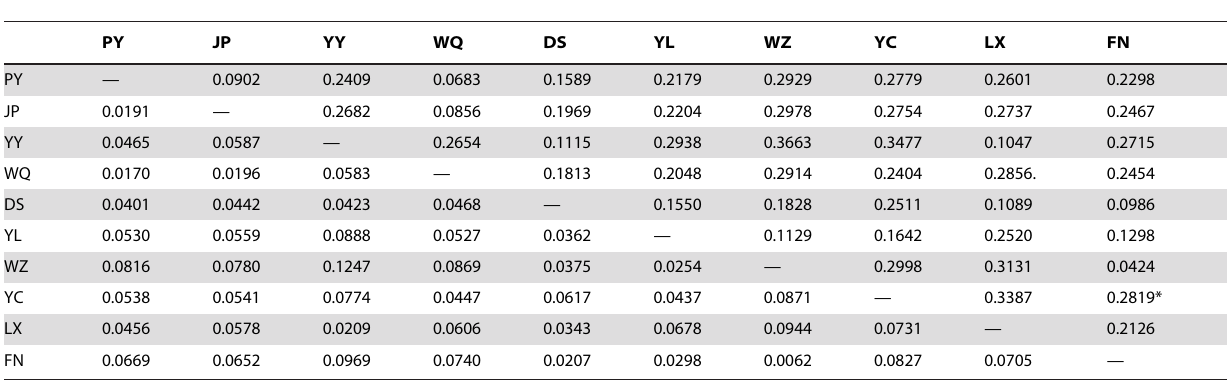
Nei’s genetic distances are below the diagonal. F ST value and their significance level are above the diagonal. Significance level of associated F ST value are shown as: *0.01 , P , 0.05, unmarked mean P ,